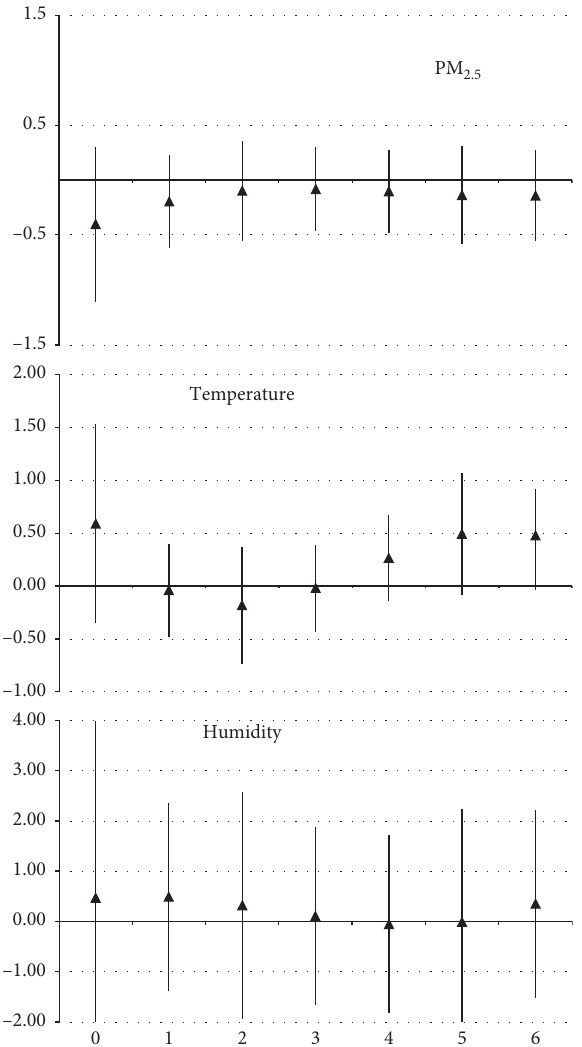
Figure 1: One interquartile range increase of daily mean level of PM 2.5 , using polynomial distribution, for hospitalizations due to respiratory diseases in children under 5 years in Manaus (AM), from 2008 to 2012. Figure 2: One interquartile range increase of daily mean level of PM 2.5 , for hospitalizations due to respiratory diseases in patients over 60 years of age in Manaus (AM), from 2008 to